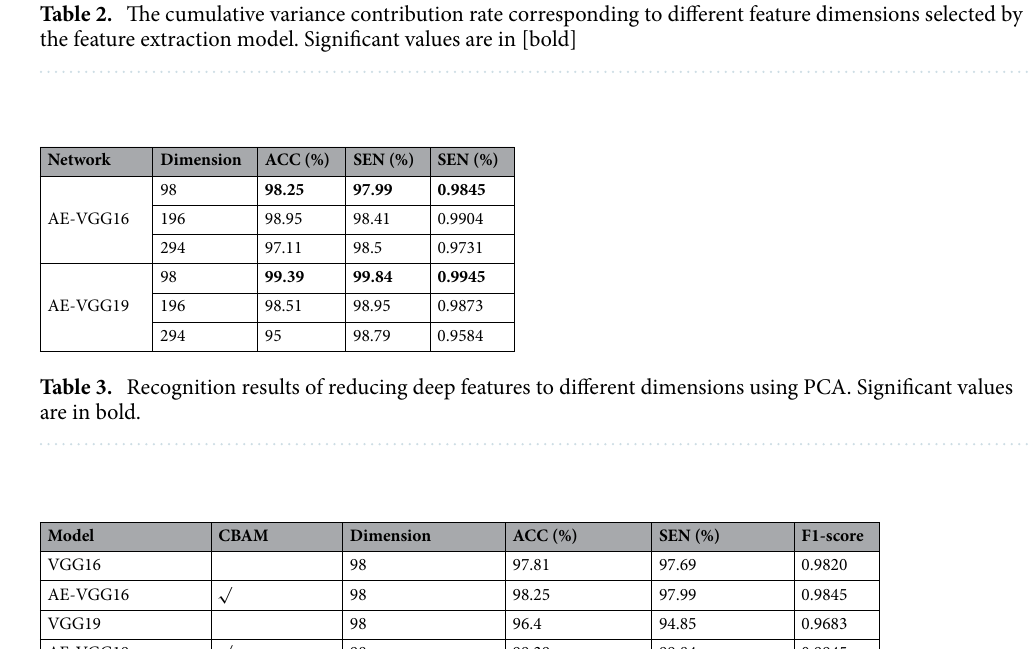
Table 4. The cumulative variance contribution rate corresponding to different feature dimensions selected by the feature extraction mode. Significant values are in bold.